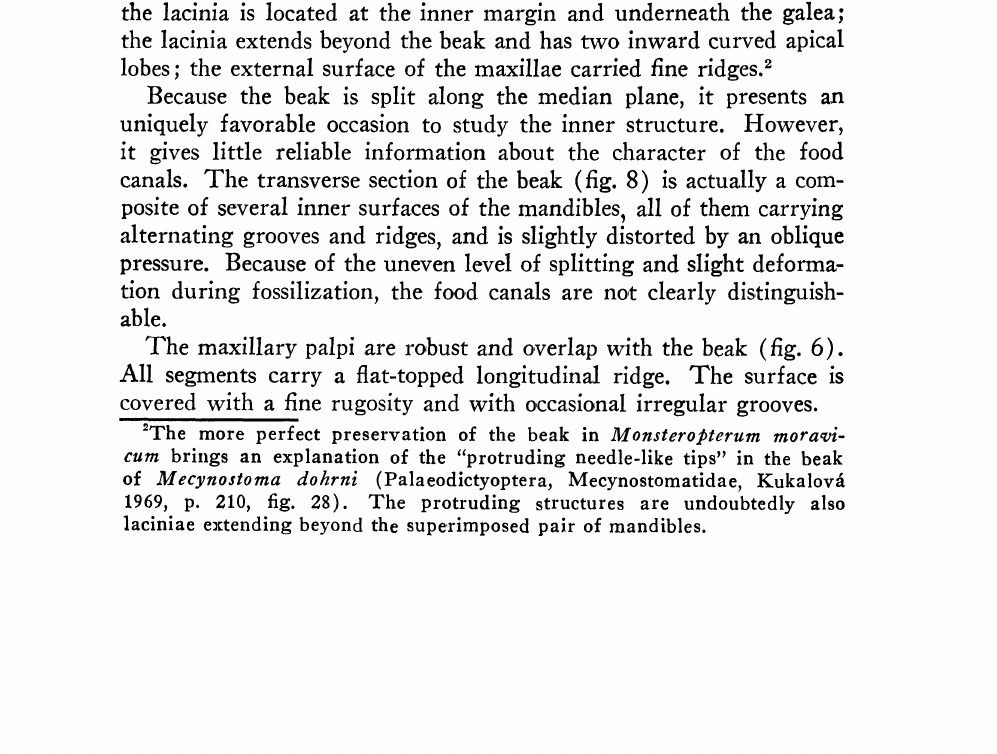
Figure 8. Bloekdiagram representing section of the beak between A and B (see fig. 7), in ventral view. Left part (Md, indicated by bracket) is probably the natural inner surface of the mandibular styler where it contacts maxillary styler. Right part is a composite of several inner our- t:aces of the hollow mandible. Oval elevations (E) and crescent-shaped pits (P) are probably opposite ends of short perpendicular pillars, which crossed the mandibular cavity and supported it t:rom inside. Original. Lower Permian of